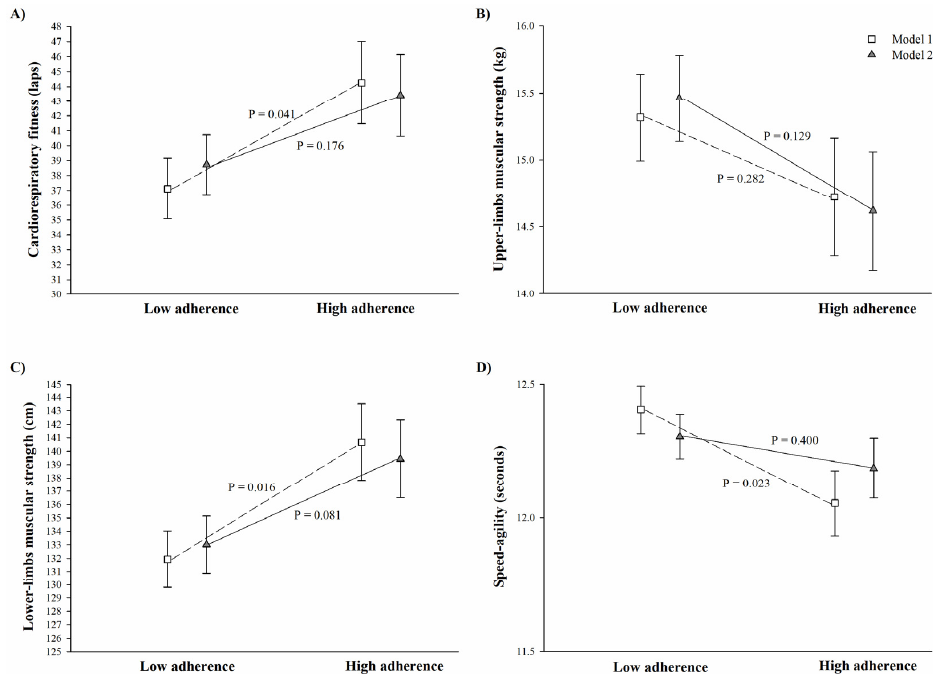
Figure 1. Differences between low and high adherence to the Mediterranean dietary pattern and physical fitness components in children ( Panel A : cardiorespiratory fitness, Panel B : upper-limbs muscular strength, Panel C : lower-limbs muscular strength, and Panel D : speed–agility).